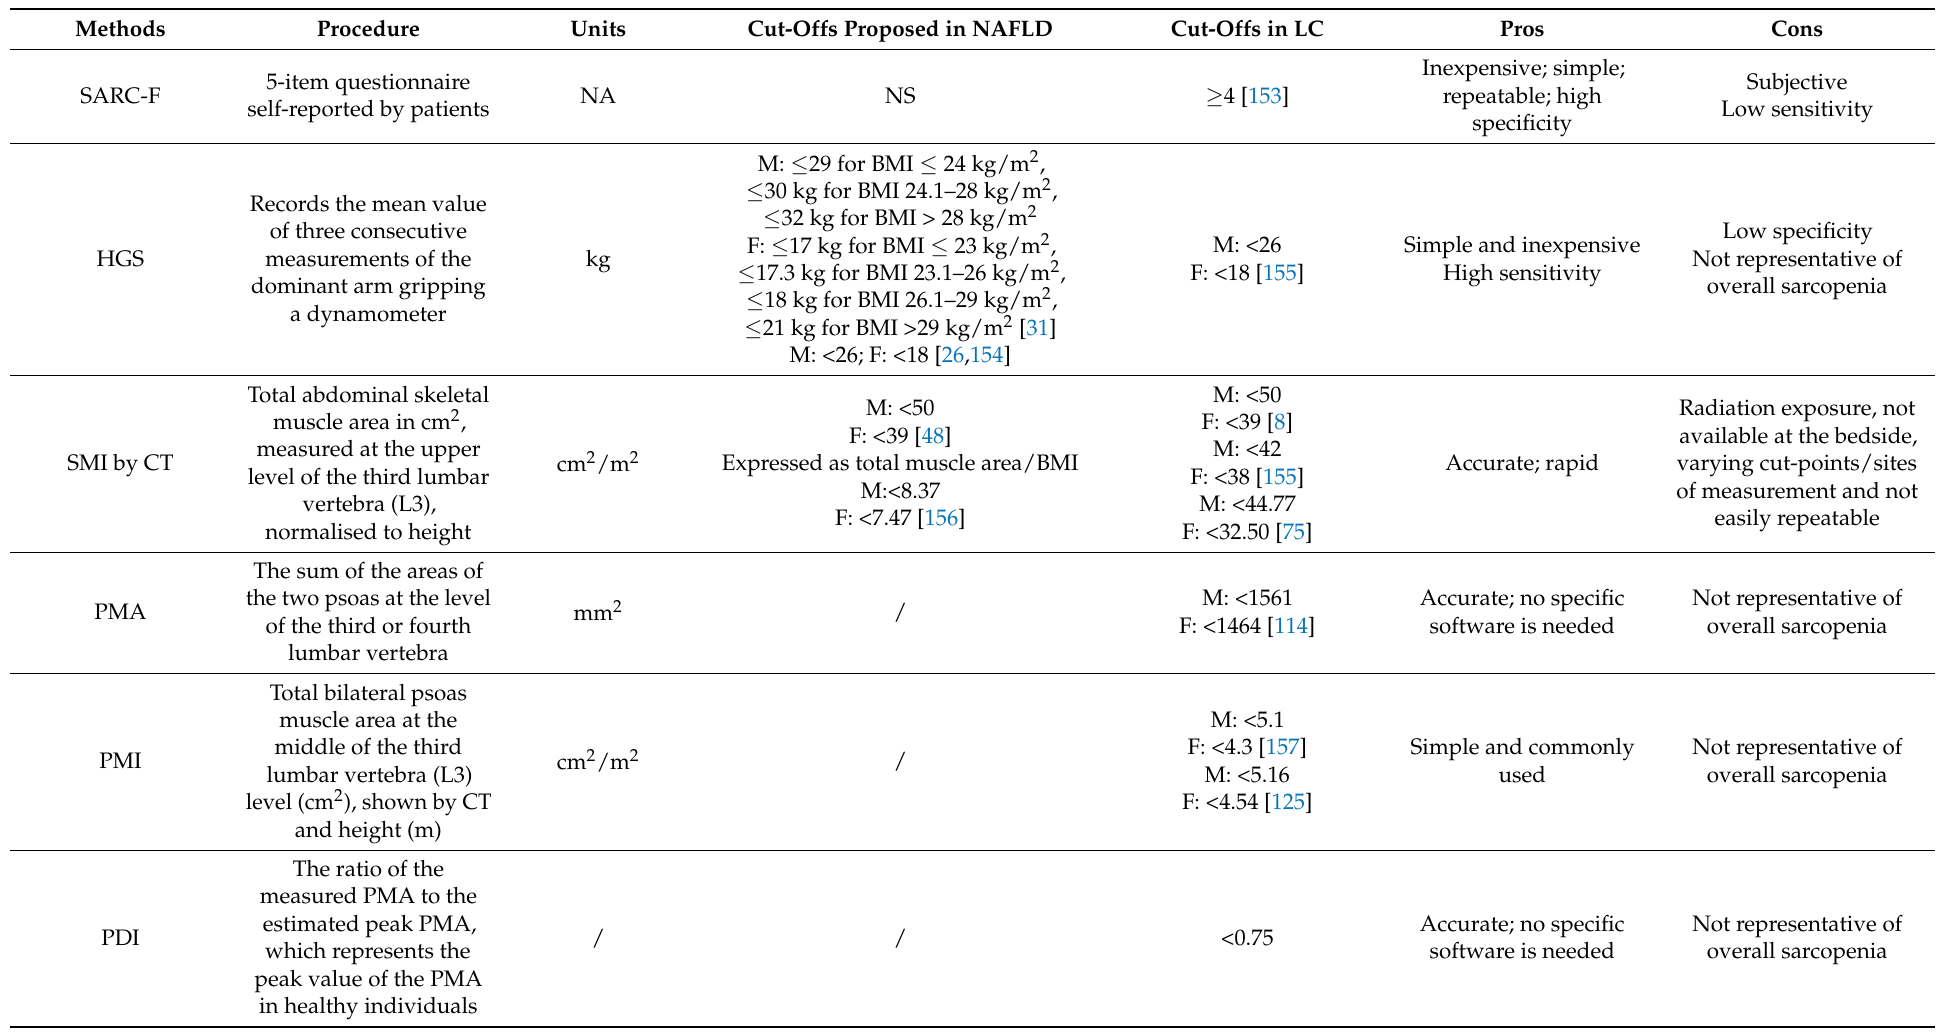
Table 1. Methods to assess sarcopenia in patients with chronic liver disease and